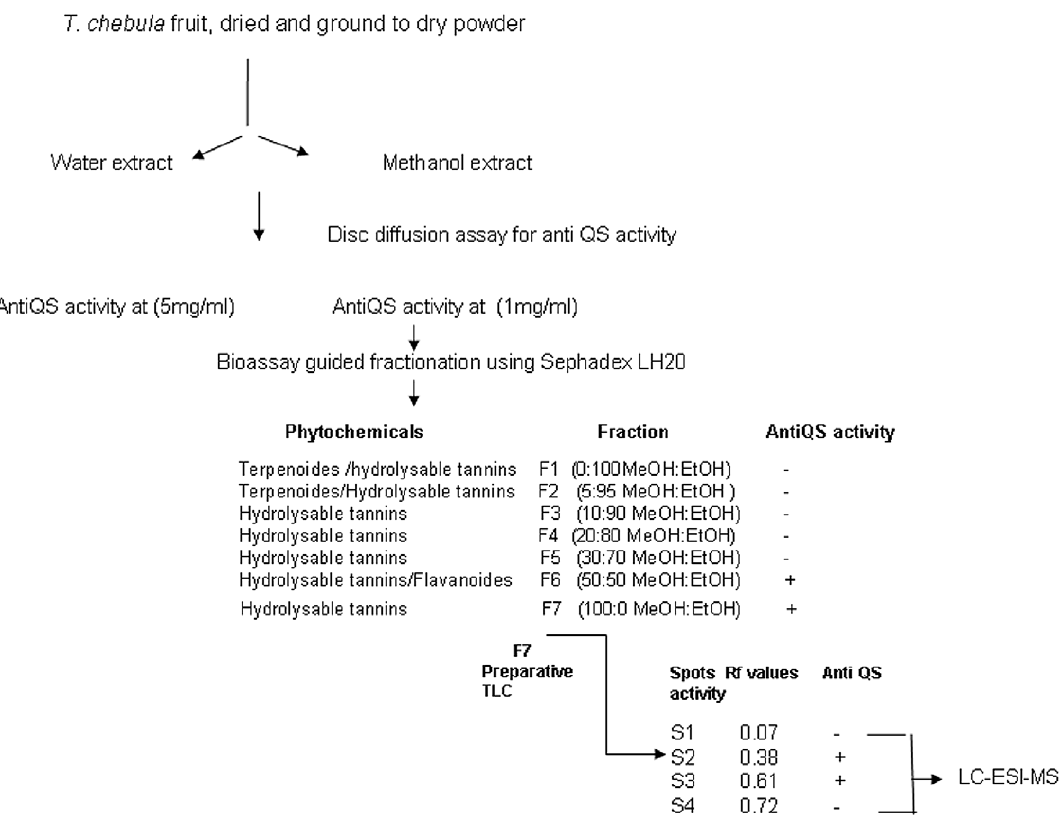
Figure 1. Schematic representation of bioassay guided fractionation of T.chebula fruit extract.